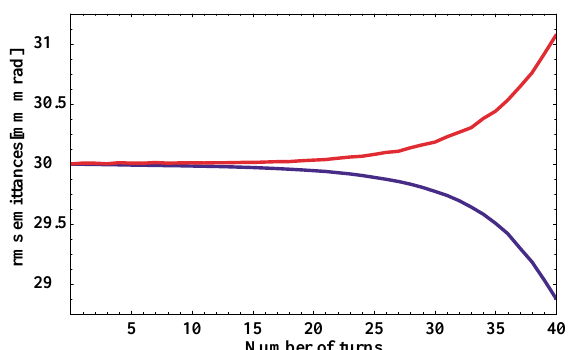
FIG. 19. (Color) ACCSIM run for the distribution with initial asymmetry. Time evolution of rms emittances for working point with zero-current tunes (cid:1) n x , n y (cid:2) (cid:1) (cid:1) 5.82, 5.75 (cid:2) . Emittance in x is shown in blue and emittance in y is shown in